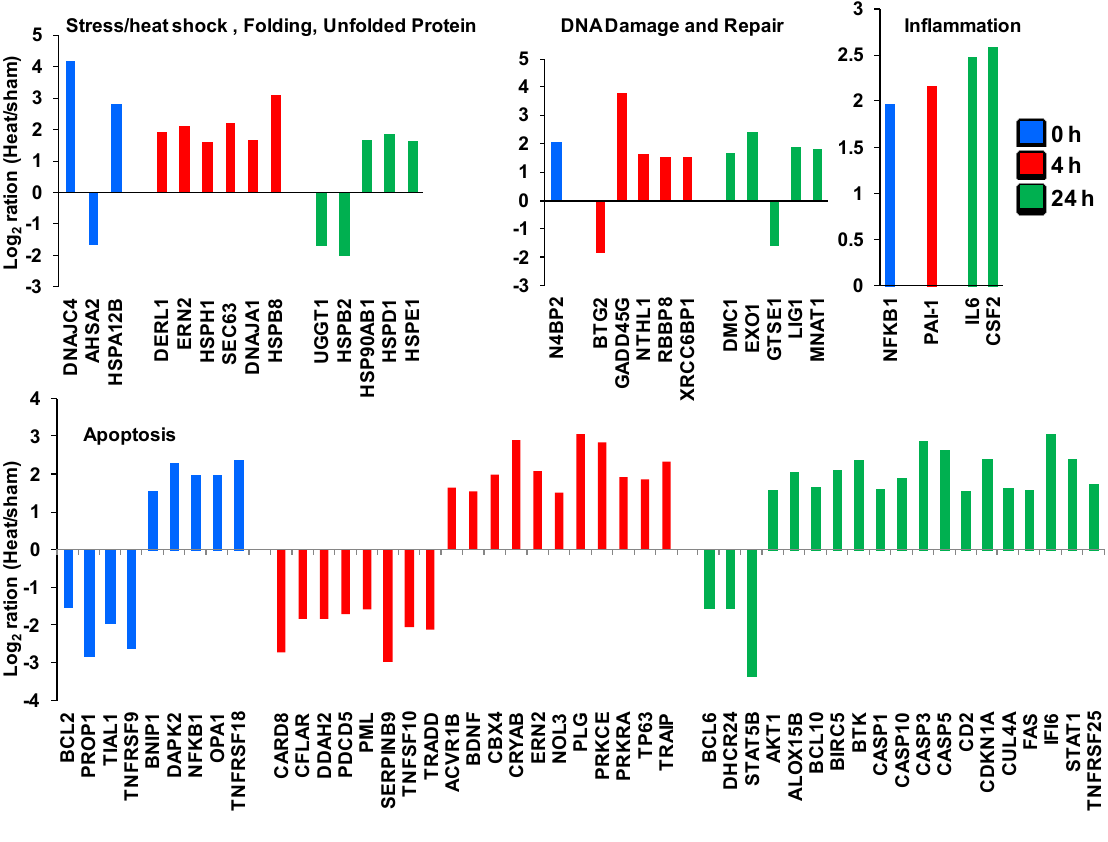
Figure 9. Gene expression profiles for a set of unique genes involved in several well-characterized pathways of the cellular stress response.